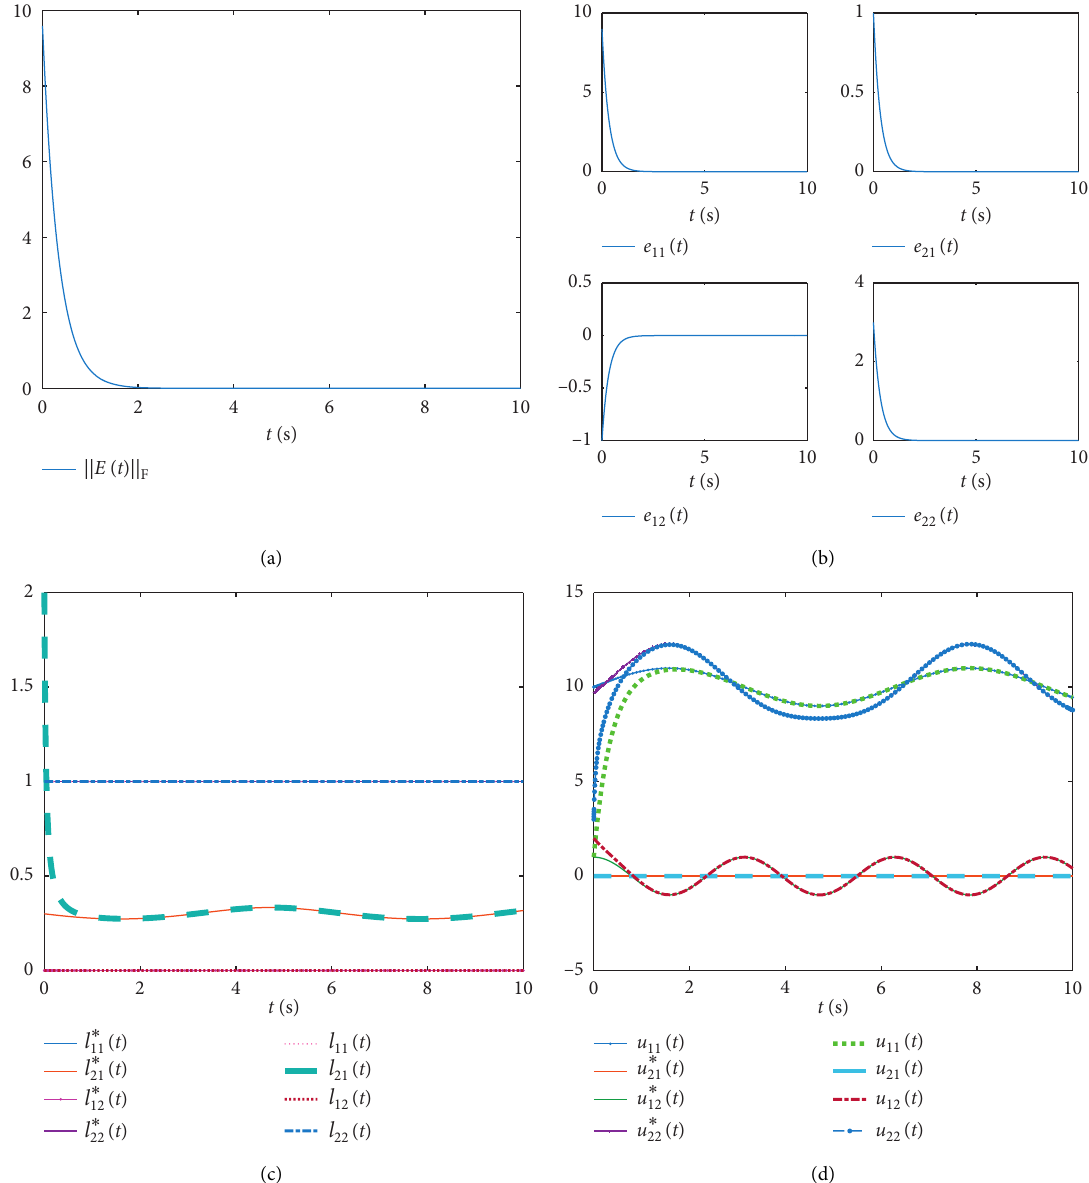
Figure 2: Experiment results synthesized by CTLUD model with λ � 3 and s ( 0 ) � 2 1 2 3 􏼂 􏼃 T for solving 2-dimensional time-varying LU decomposition problem in Example 1. (a) Frobenius-norm trajectory of error matrix E ( t ) . (b) Trajectories of e